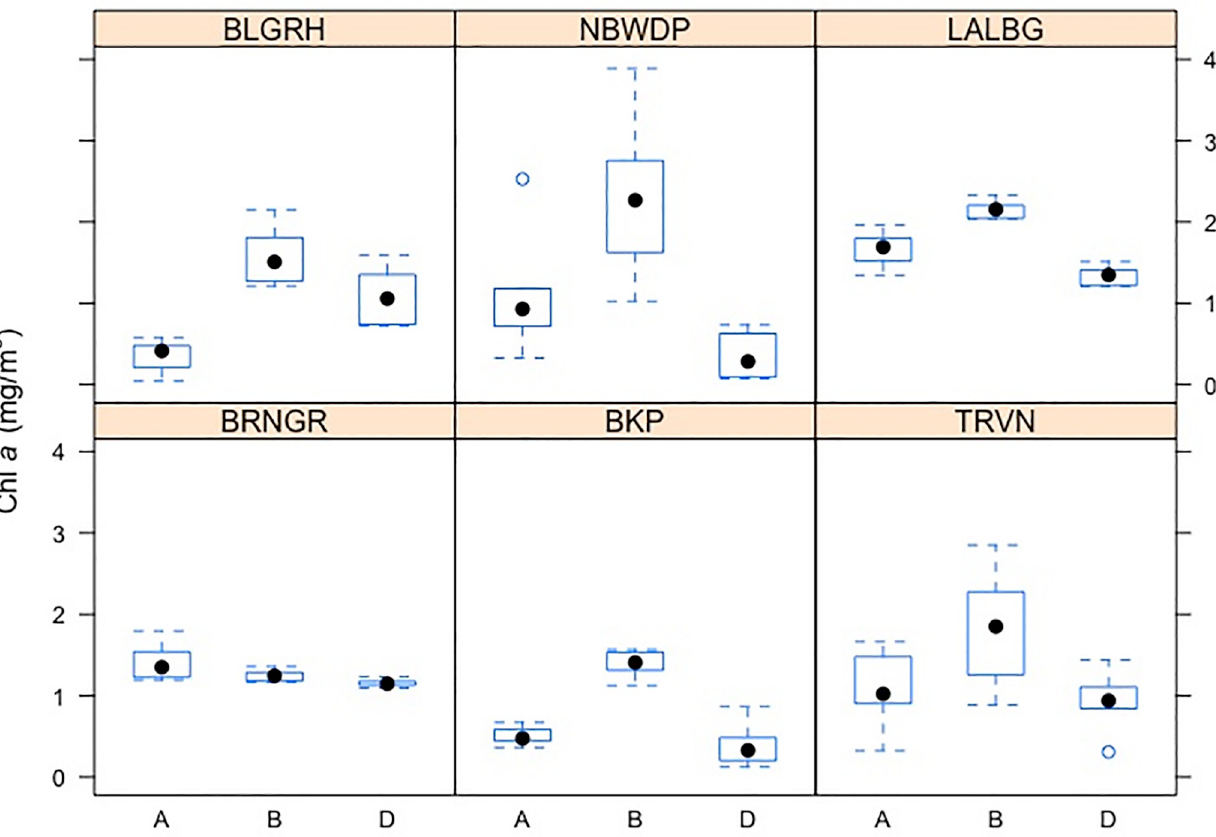
Fig 9. Effect of barge movement at each of the sampling station. Sampling locations are abbreviated as follows—BRNGR: Baranagar; BKP: Barrackpore; TRVN: Triveni; BLGRH: Balagarh; NBDWP: Nabadweep; LALBG: Lalbag. X axis depicts instances of Chl a data collection along Bhagirathi Hooghly river stretch with respect to ‘barge movement’; A: 30 minutes after barge; B: 30 minutes before barge, D: During ‘barge movement’;Y axis denotes Chl a biomass (mg/m 3 ) at respective